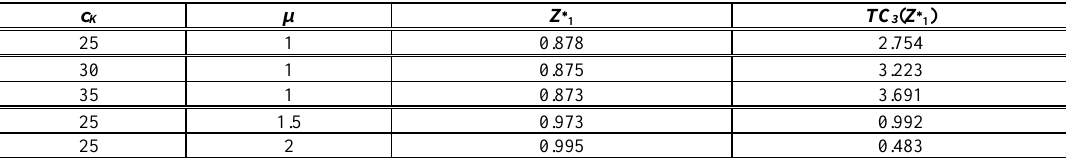
Table 3. Optimal Z ∗ 1 and TC 3 ( Z ∗ 1 ) of Model 3 for K =25, 30, 35 and 𝜇 = 1, 1.5, 2 when T = 1 and L =10.